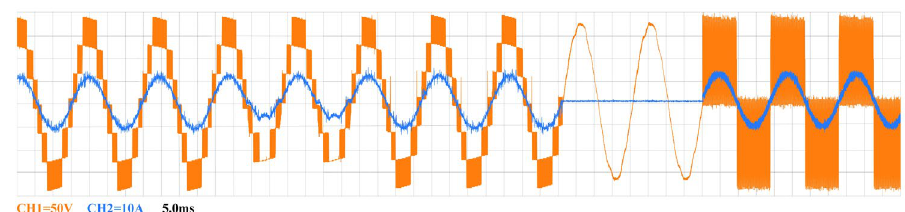
Figure 10. Experimental results of serial fault-tolerant control.